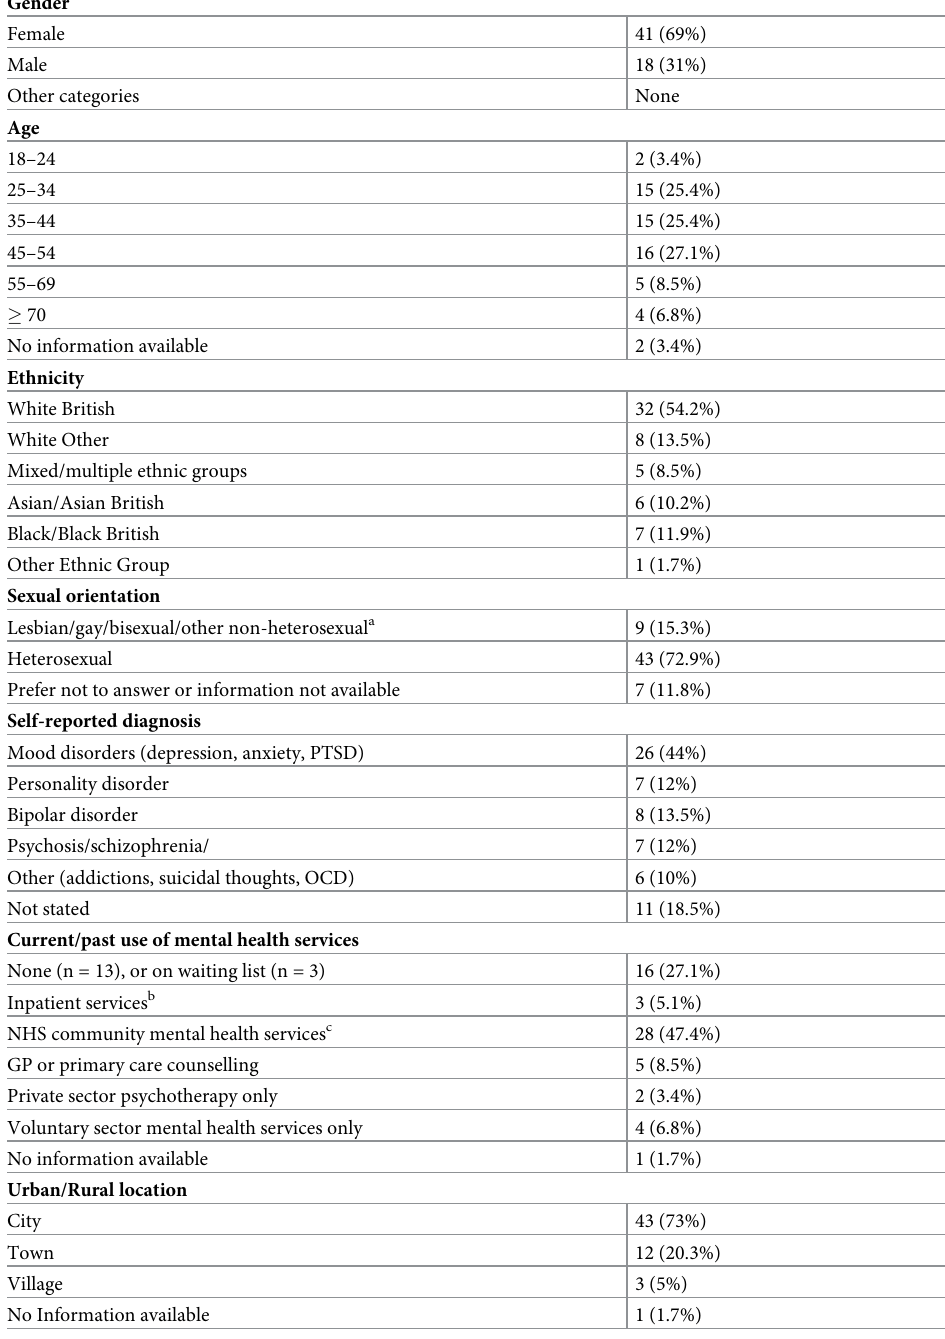
Table 1. Demographics of 59